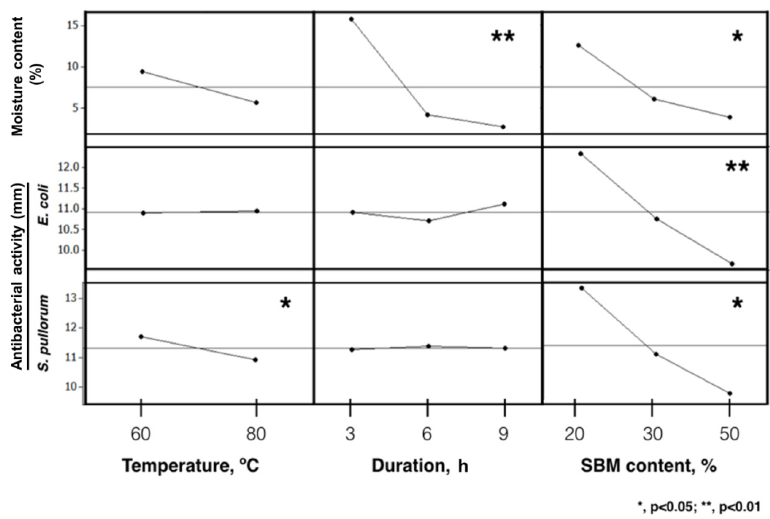
Figure 1. Effect of different drying conditions on moisture content and antibacterial activity of CC products. Figure 1. EffectofdifferentdryingconditionsonmoisturecontentandantibacterialactivityofCCproducts. Table 5. Effect of different drying durations (h) at 60 °C on moisture content and antibacterial activity Table 5. E ff ect of di ff erent drying durations (h) at 60 ◦ C on moisture content and antibacterial activity of the CC products with 20% SBM content. of the CC products with 20% SBM